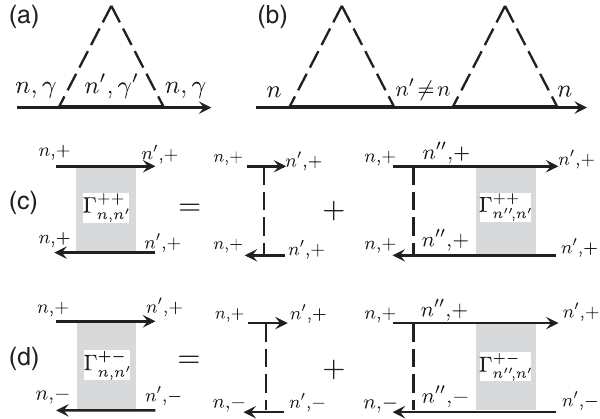
FIG. 7. The diagrammatic representation of (a) the self- consistent self-energy, Eq. (47), (b) an example of a subleading in ð Δ E τ Þ − 1 contribution. (c),(d) The Dyson equation, Eq. (53), satisfied by a scattering amplitude Γ þþ and Γ þ − , respectively. n;n 0 n;n 0 Solid arrowed lines denote Green ’ s functions. The dashed lines stand for disorder averaged scattering